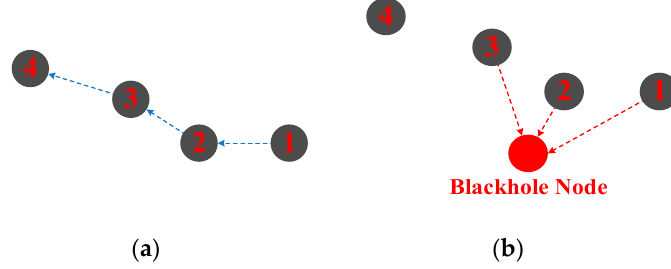
Figure 6. Black hole attack; ( a ) normal route; ( b ) black hole route.